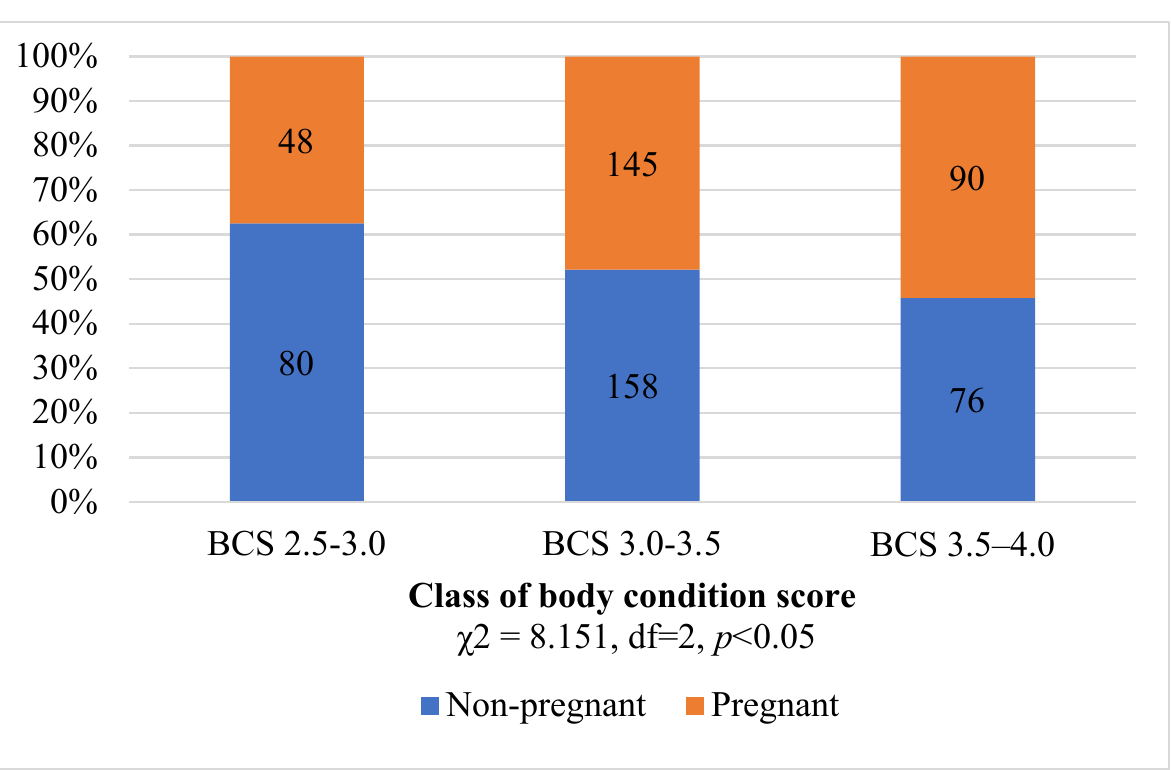
Figure 1. Relation of body condition score with the pregnancy status of cows from the day of oestrus to 7 days post ‐ oestrus.